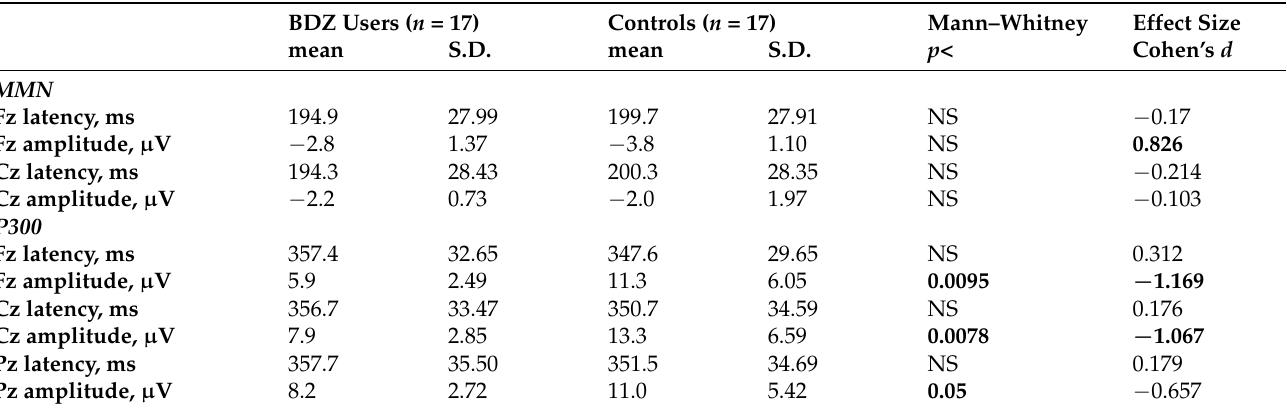
Figure 1. Topographic maps and grand averages of the MMN traces obtained in controls (thick lines) and BDZ users (thin lines) from the midline EEG electrodes. The two vertical dotted bars indicate the approximate extent of the MMN component of ERPs. Table 2. Comparison between ERPs